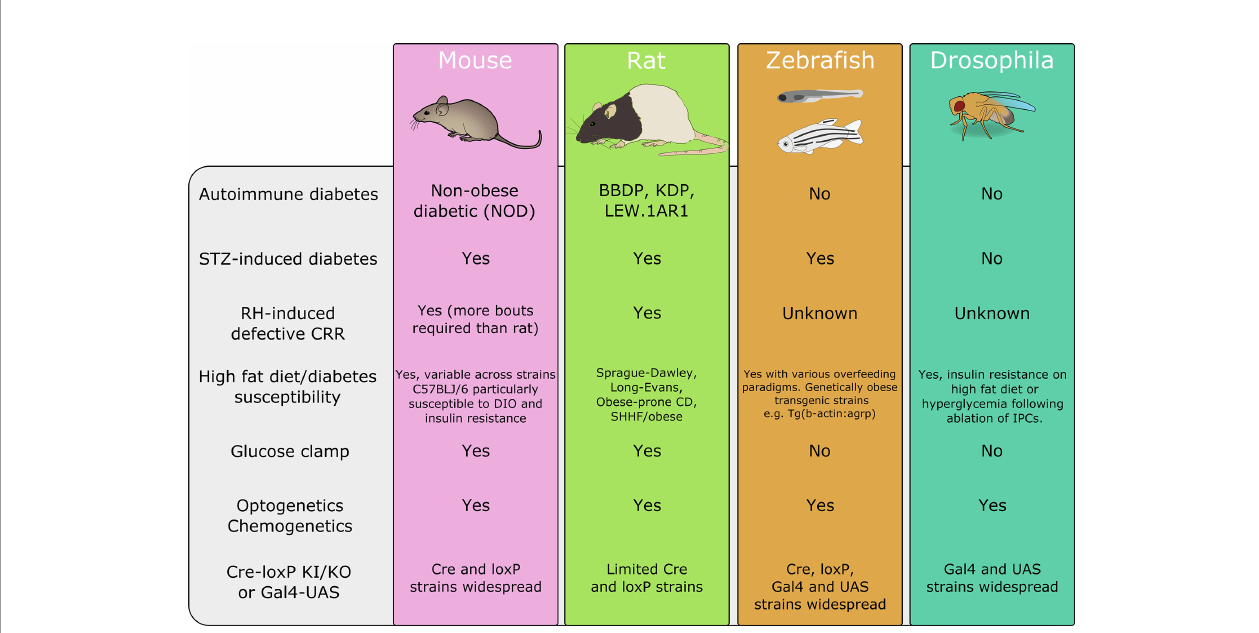
FIGURE 2 | A summary of disease models and techniques available in each of the discussed organisms. BBDP, biobreeding diabetes-prone; DIO, diet-induced obesity; IPC, insulin-producing cell; KDP, Komeda diabetes prone; SHHF, spontaneously hypertensive hear failure; UAS, upstream activation sequence. This is a summary and is not intended as an exhaustive list. Animal images adapted from